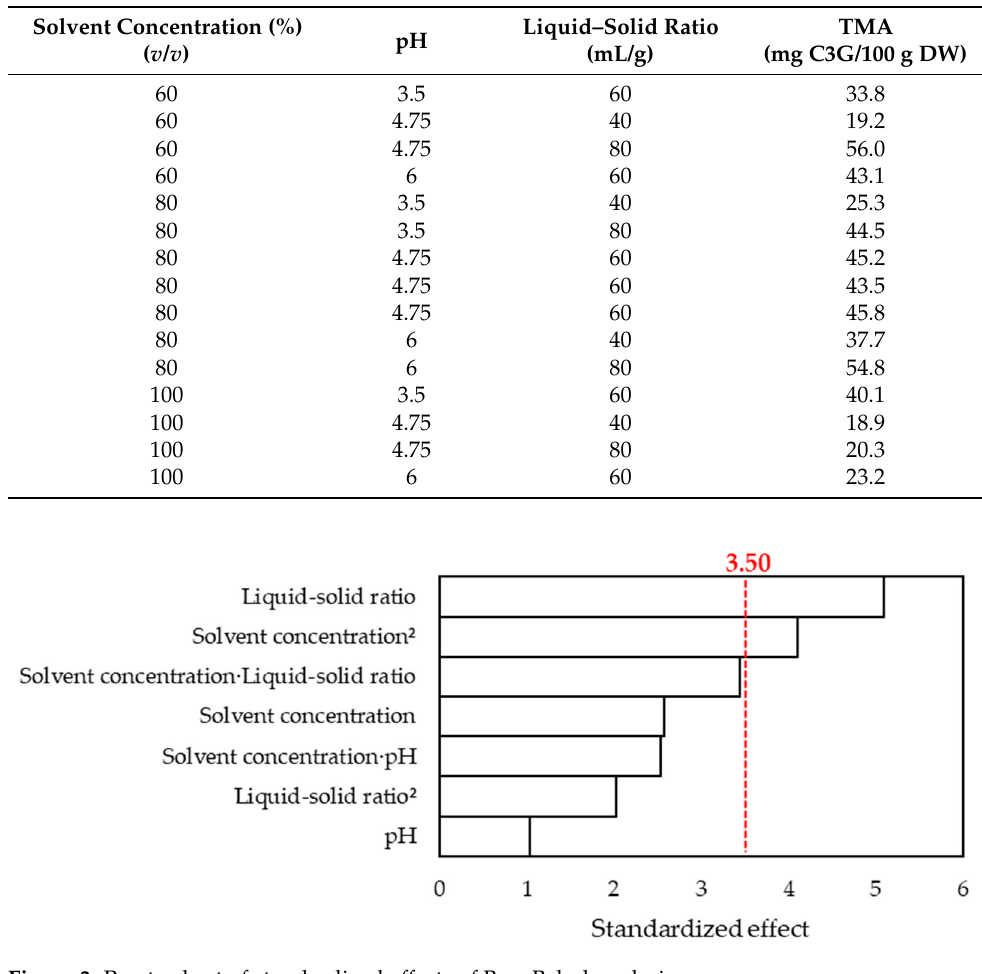
Figure 3. Pareto chart of standardized effects of Box–Behnken design. Equation (2) expresses the regression of the model for the concentration of total mon- omeric anthocyanins (TMA) expressed in mg C3G/100 g DW. This equation predicts the TMA concentration and allows the response surface to be obtained, as shown in Figure 4. Figure 4A shows the response surface for the interaction between the solvent concen- tration and pH. As depicted, the concentration of anthocyanins extracted is favored with the increase in pH and the decrease in the concentration of the solvent. ( A ) ( B )